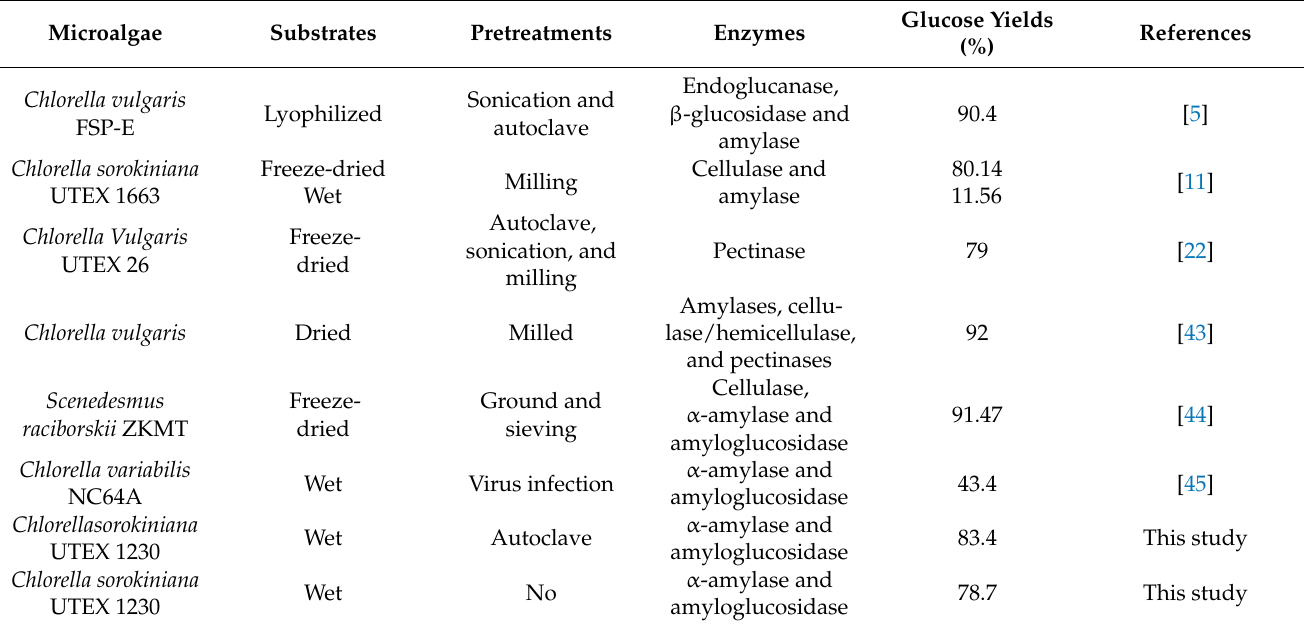
Table 3. Glucose yields from algal biomasses obtained by enzymatic